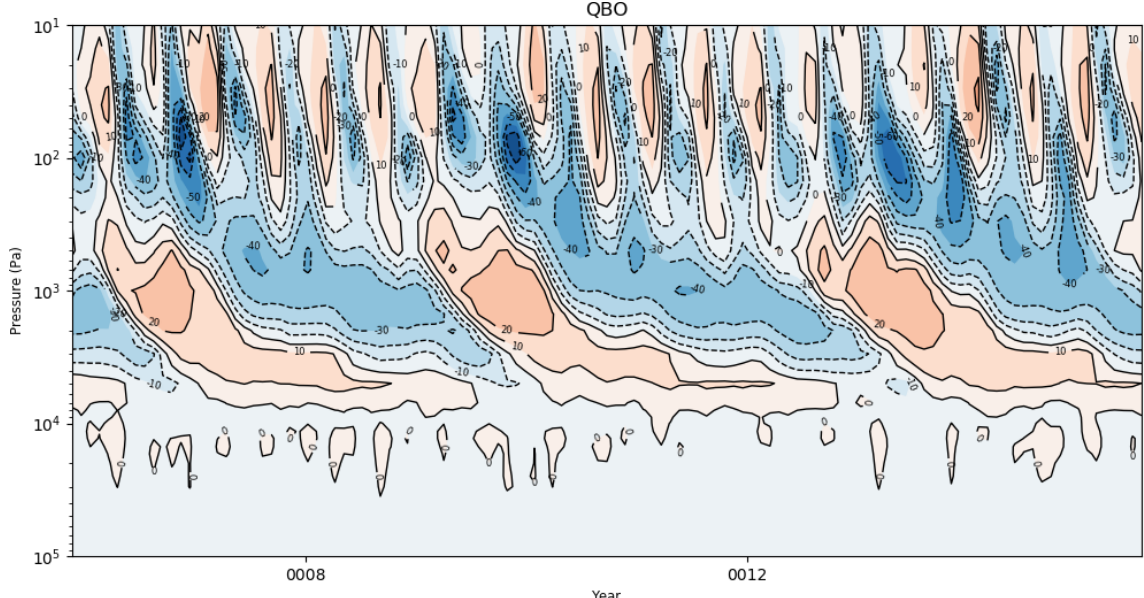
Figure 4. AutoAssess diagnostic for the Quasi-Biennial Oscillation (QBO) showing the time–height plot of zonal mean zonal wind averaged between 5 ◦ S and 5 ◦ N for UKESM1-0-LL over the period 1995–2014 in ms − 1 . Produced with recipe_ autoassess_*.yml. ; see details in Sect.